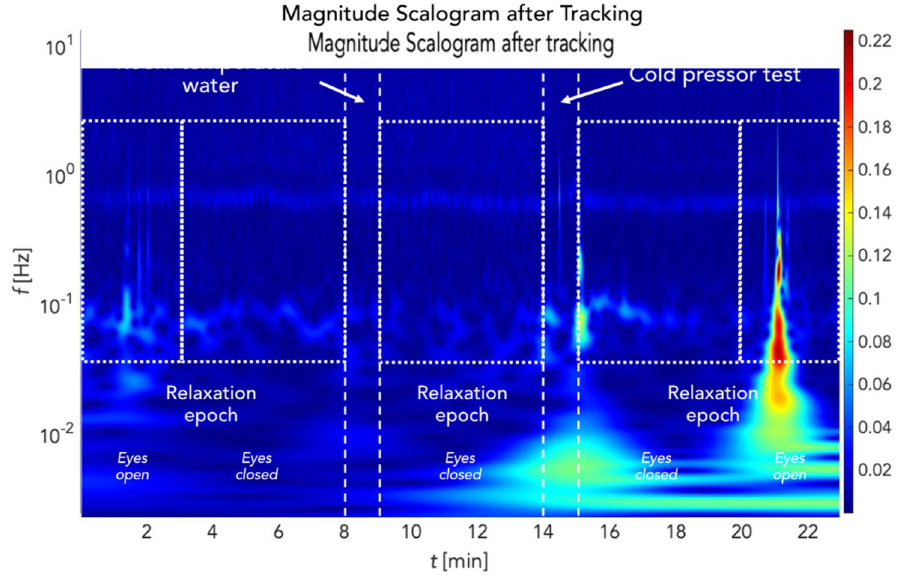
Figure 5. Continuous wavelet scalogram after tracking.